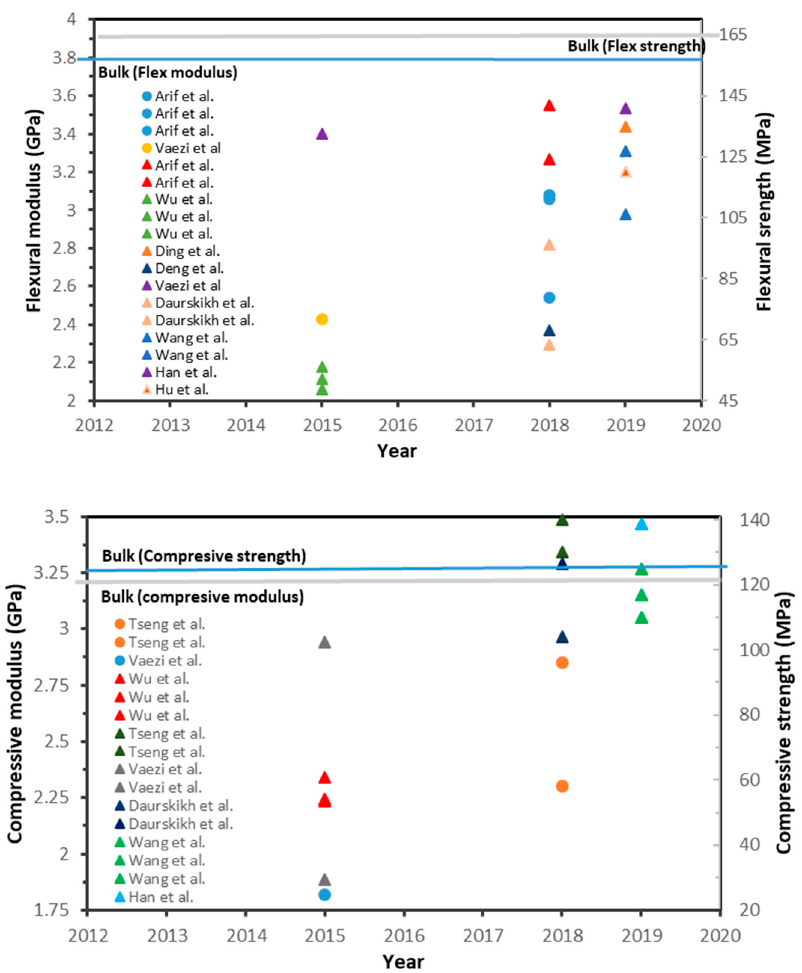
Figure 3. Flexural and compressive properties values for 3D-printed PEEK reported in the literature. Triangle and circle symbols are strength and modulus data, respectively.